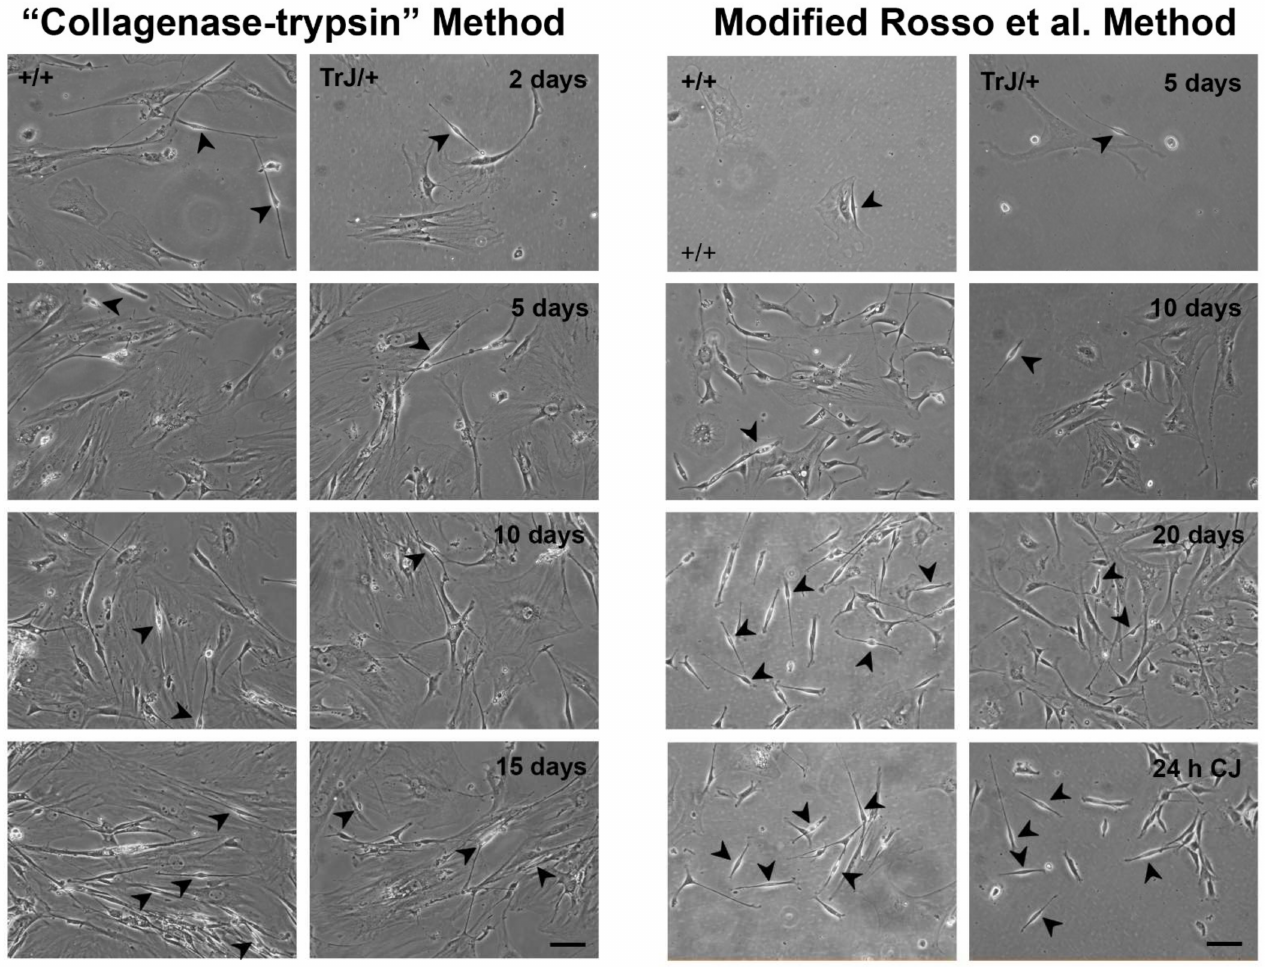
Figure 2. Enriched SC–FB cultures obtained by different protocols. Images of mixed primary culture obtained from the “collagenase-trypsin” protocol are visualized in the left panels in the +/+ and TrJ/+ cultures. This protocol allowed the obtaining of a large number of cells in eight days, but the SC/FB ratio is rather low, as observed after 15 days of seeding. Images of the mixed primary culture obtained with the modified protocol of Rosso et al., 2017 [71] in +/+ and TrJ/+ are displayed in the right panels. This method requires more time to obtain a large number of cell volumes. The epineurium removal and enrichment by Cold-Jet (CJ) allowed us to obtain a higher SC/FB ratio, compared to the collagenase-trypsin protocol. Arrowheads point to SCs. Scale = 250 µ m for all